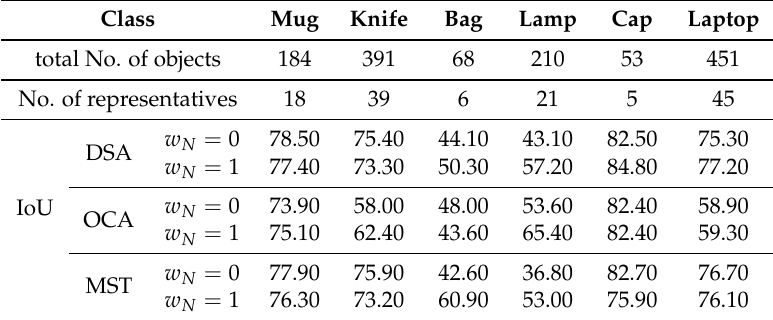
Table 2. Accuracy of the automatic component annotation. DSA, direct segment association; OCA, object-constrained association; MST, minimum spanning tree.